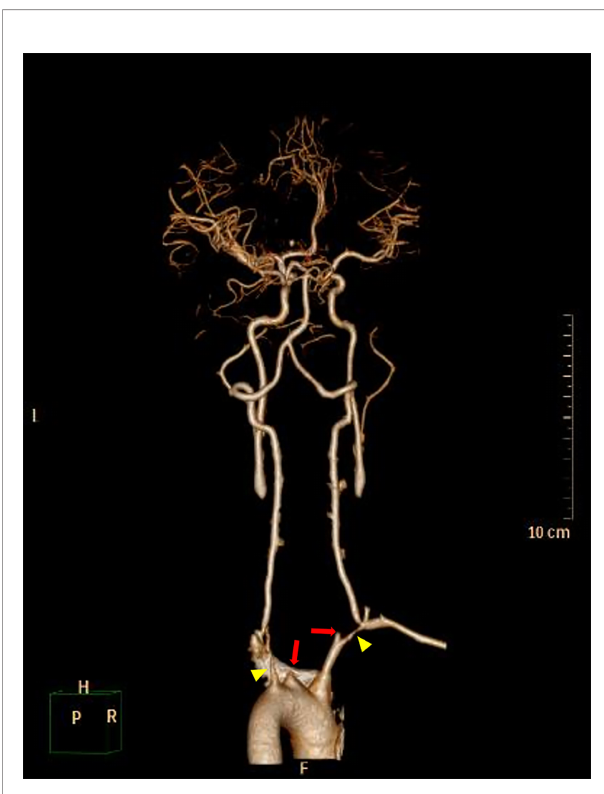
FIGURE 4 | 3D-reconstructed CT angiography (CTA) before balloon angioplasty shows complete occlusion of bilateral common carotid arteries (red arrows) and severe stenosis of bilateral proximal subclavian arteries (yellow arrowheads). Associated thrombi completely occluding bilateral common carotid arteries were also